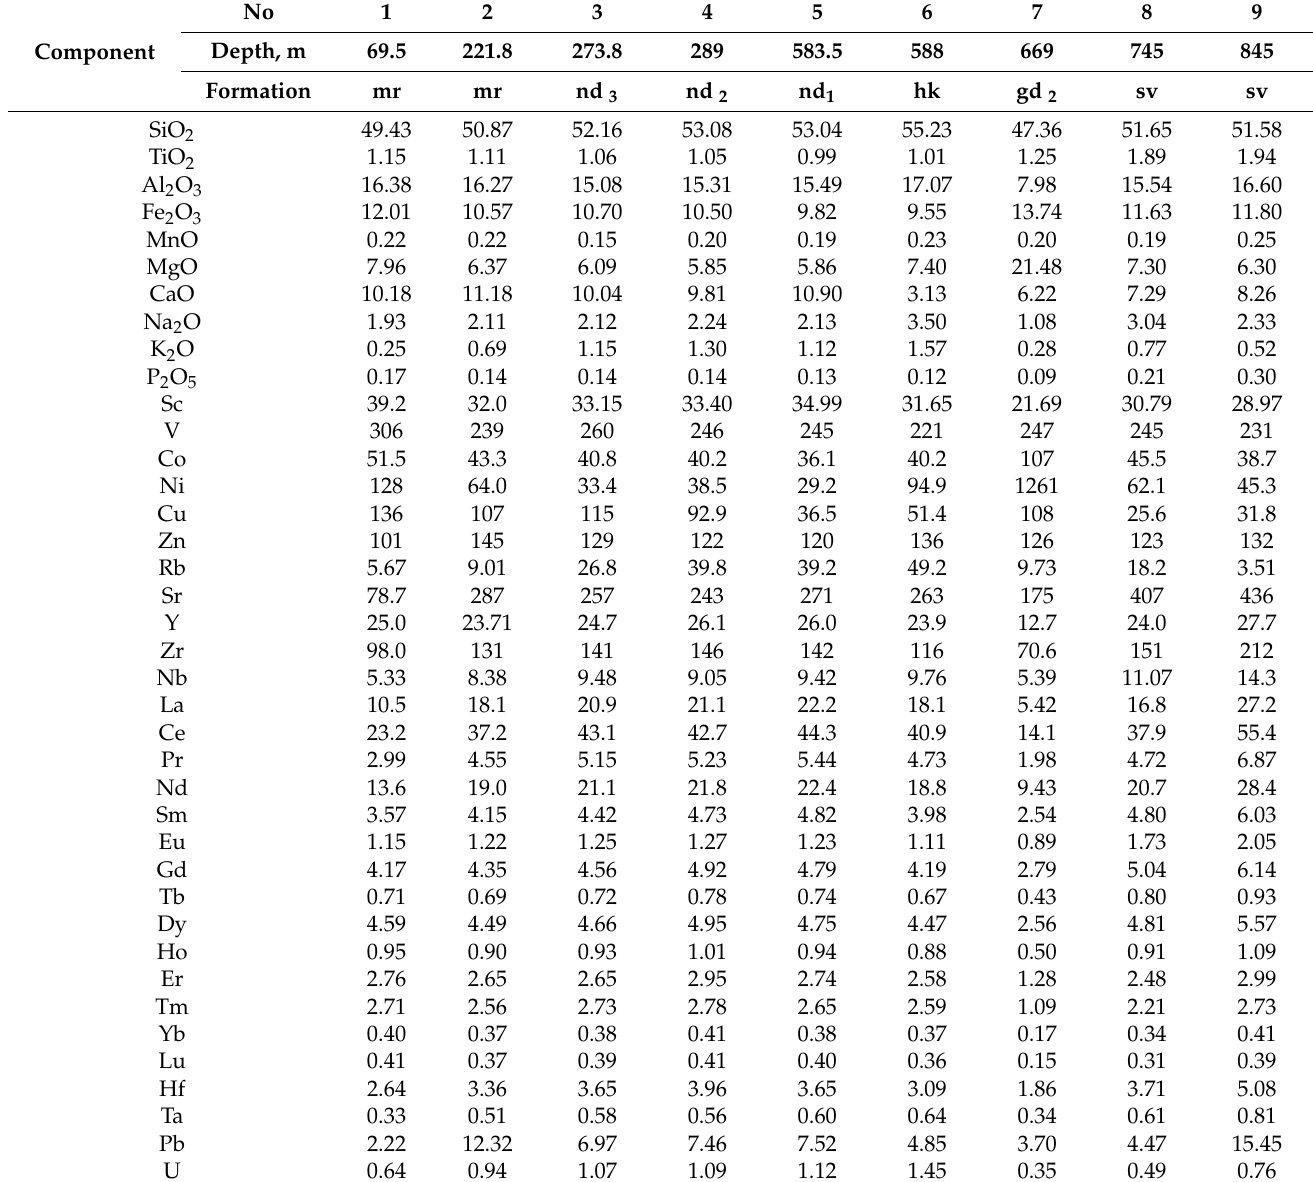
Table 2. Representative volcanic rock compositions in borehole